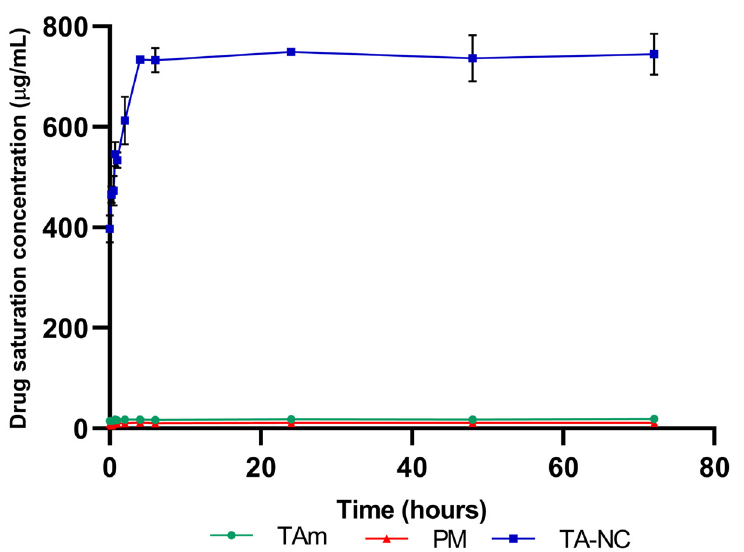
Figure 9. Drug saturation concentration studies of TA-NC, mTA and PM in the simulated tear fluid at 37 °C. Results are presented as means ± SD ( n = 3).